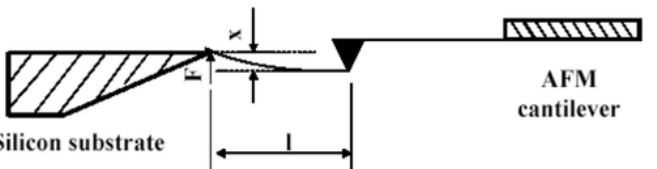
Figure 17. Schematic of shear modulation force microscopy. Reprinted from [29] with permission from AIP Publishing .